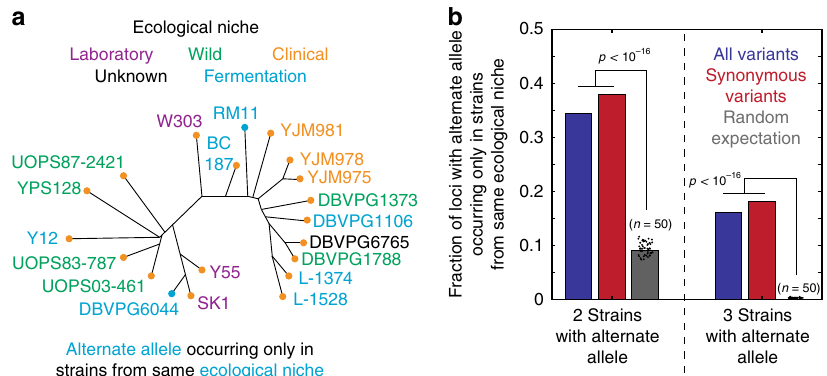
Fig. 7 Enrichment of shared alternate alleles in common ecological niches. a Schematic of a phylogeny in which the alternate (RM11) allele occurred twice, and only in the fermentation niche. b Fraction of variants segregating in the SGRP collection for which the alternate allele occurs only in strains from same ecological niche (blue: all variants; red: only synonymous variants), for loci with the alternate allele occurring (left) in two strains or (right) in three strains; the neutral expectation was calculated by 50 independent simulations; the mean of the simulations and the results of each simulation are shown in gray and with black dots, respectively. p values by permutation test. Source data are provided as a Source Data